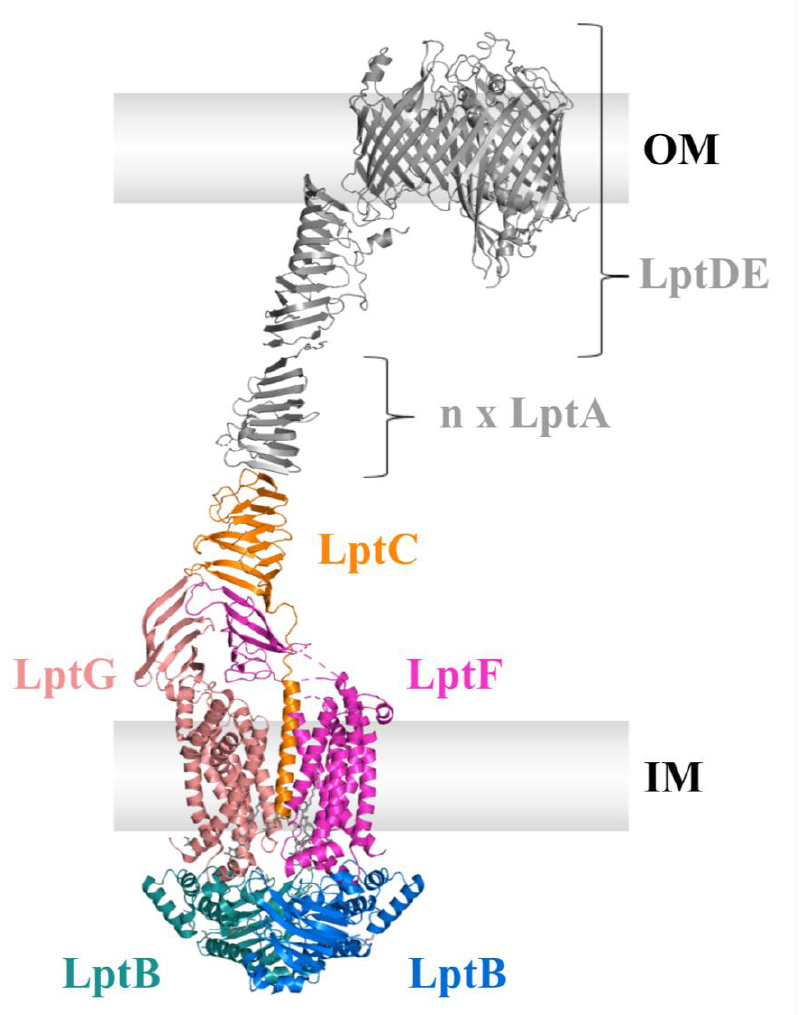
Figure 6. Overview of the Lpt machinery spanning both membranes and the periplasm. Note that the number of LptA oligomers forming the periplasmic bridge is unknown. The figure was created using PyMOL and the PDB entries of LptDE (5IV9, grey in the outer membrane), LptA (2R19, grey in the periplasm), and LptB 2 FGC (6MJP, orange, salmon, light magenta, deep teal and marine in the inner membrane). The outer membrane (OM) and inner membrane (IM) are displayed as grey boxes. The peptidoglycan layer is omitted for reasons of clarity.